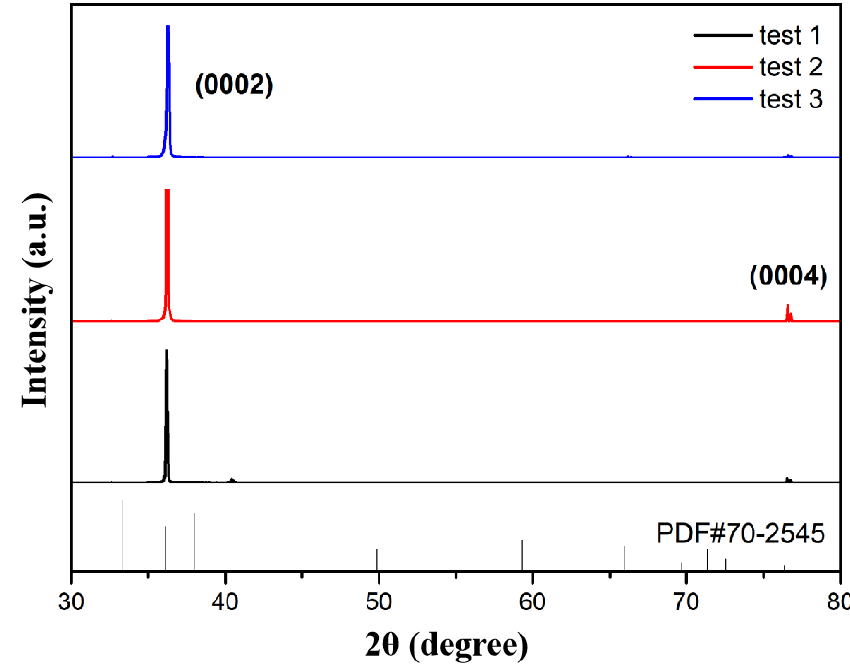
Figure 8. XRD diffraction pattern of AlN wafer.